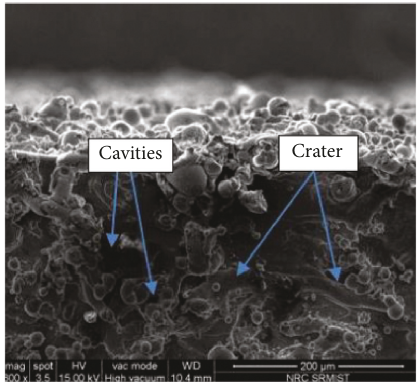
Figure 4: Machined surface using heat-treated brass tool with 300x magnification.